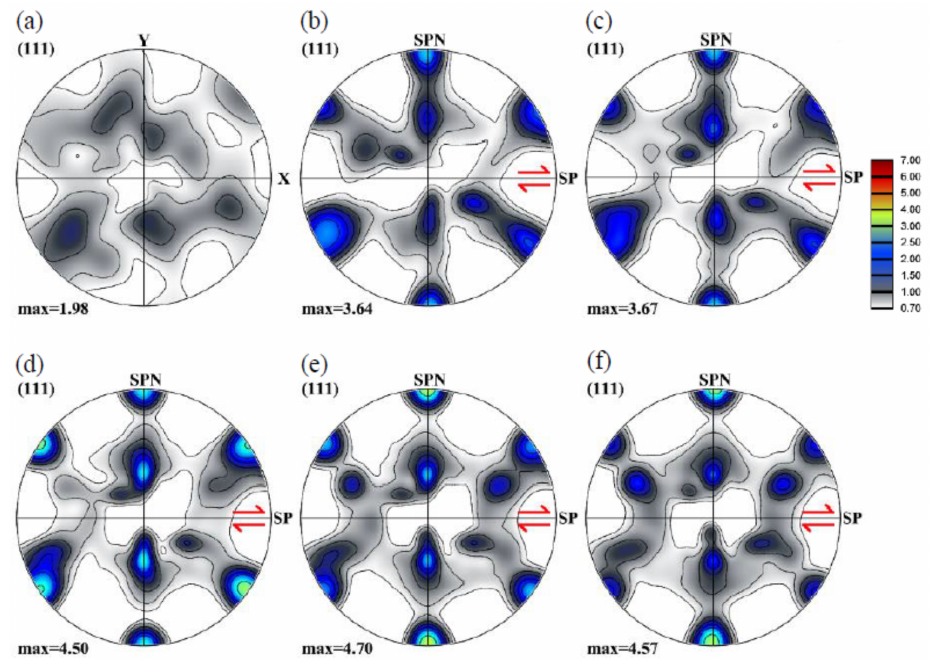
Figure 8. Texture evolution in {111} pole figures of a 3D polycrystal with cube-type initial texture at shears of 0 ( a ), 1 ( b ), 2 ( c ), 6 ( d ), 6 ( e ), and 8 ( f ). (SP indicates the shear plane, and the arrow is orientated in the shear direction; SPN is the shear plane normal).